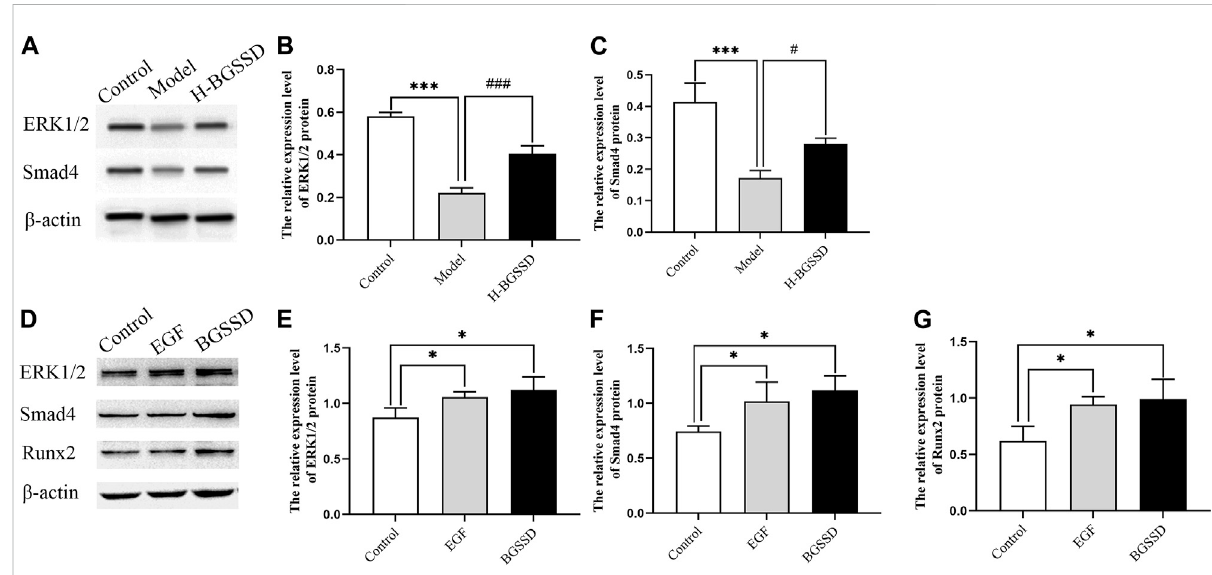
FIGURE 5 In vivo , BGSSD induced overexpression of ERK1/2, Smad4 protein of SAMP6. (A) Representative images of WB. (B,C) The quanti fi cation of the protein expression level of ERK1/2, Smad4, samples were collected from the bone tissue. Values were expressed as mean ± SD, *** p < 0.001, versus the control group; # p < 0.05, ### p < 0.001, versus the model group. In vitro , BGSSD medicated serum enhanced ERK1/2, Smad4, and Runx2 protein expression in MC3T3-E1 cells. (D) The WB bands of the cell experiment. (E – G) the quanti fi cation of the protein expression level of ERK1/2, Smad4, and Runx2 in MC3T3-E1 cells before and after 20% BGSSD medicated serum treatment. Values were expressed as mean ± SD, * p < 0.05, compared with the control group. Furthermore, the agonist of ERK, EGF, activated the ERK1/2 protein, meanwhile, stimulated the expression of Smad4 and Runx2 protein in MC3T3-E1 cells. (D) Representative images of WB. (E – G) The quanti fi cation of the protein expression level of ERK1/2, Smad4,Runx2afterEGFinvention.Valueswereexpressedasmean±SD,* p < 0.05,versusthecontrolgroup. Alltheassayswererepeatedmorethan three